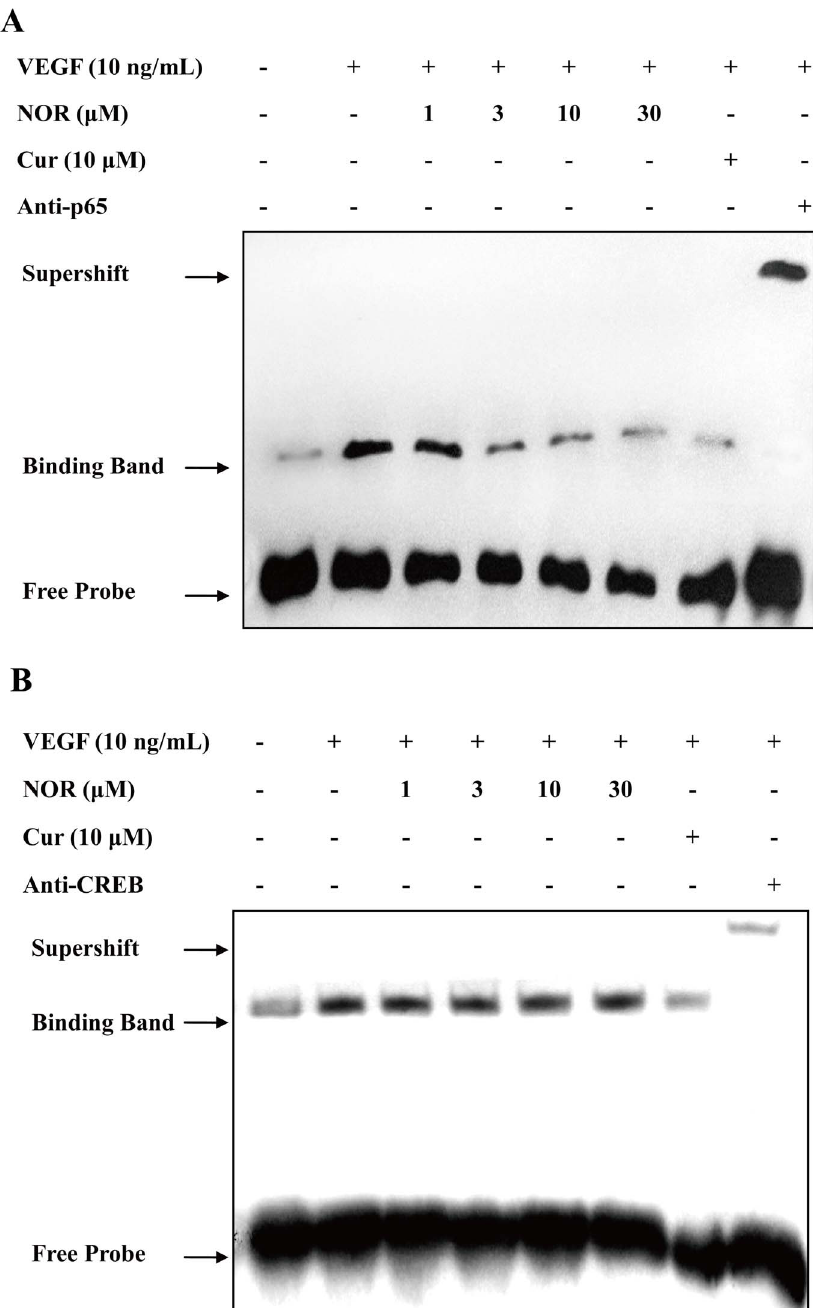
Figure 6. The effect of NOR on the VEGF-induced activation of transcription factors in the PKA pathway. ( A ). Effect of NOR on VEGF- induced NF k B activation. HUVECs were treated with NOR or Cur in the presence of VEGF for 24 h, and then harvested for EMSA analysis. ( B ). Effect of NOR on VEGF-induced CREB activation. HUVECs were treated with NOR or Cur in the presence of VEGF for 24 h, and then harvested for EMSA analysis. NOR, norisoboldine; Cur,